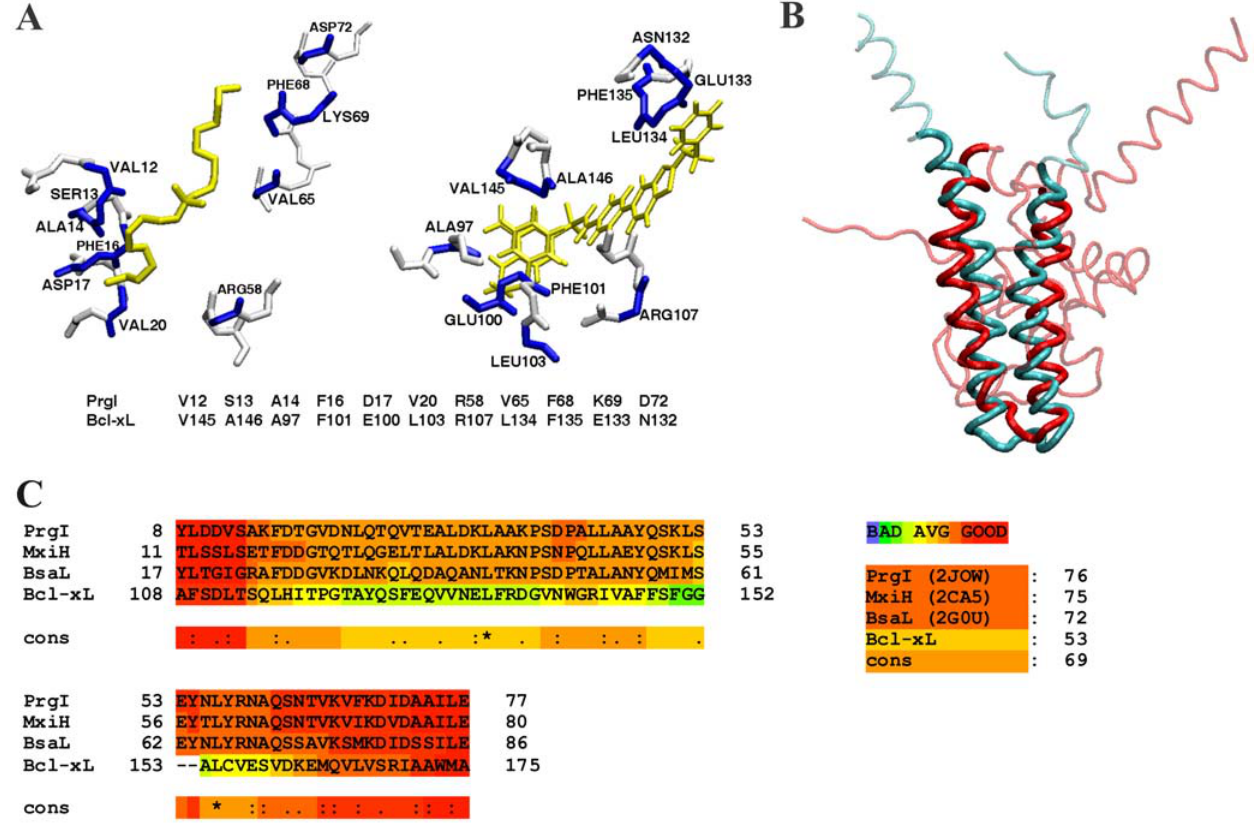
Figure 2. Active Site Similarity between PrgI and Bcl-xL. (A) CPASS alignment of the S. typhimurium PrgI active-site complexed to DDAB with the active-site of human Bcl-2 protein (Bcl-xL) complexed with acyl-sulfonamide-based inhibitor. The residues aligned by CPASS are labeled and colored blue in the structures. The active site sequence alignment is also shown below the structures. The ligands are colored yellow. (B) Overlay of the human Bcl-2 protein (red) with S. typhimurium PrgI (turquoise) based on a DaliLite [29] alignment. (C) Multiple-sequence alignment of the three known T3SS structures of S. typhimurium PrgI, B. pseudomallei BsaL, and S. flexneri MxiH with the human Bcl-2 protein (Bcl-xL). The reliability of the each amino acid alignment is color-coded from blue (poor) to red (good) using the CORE index [35]. The consensus alignment received a score of 69, where a perfect alignment receives a score of 100.